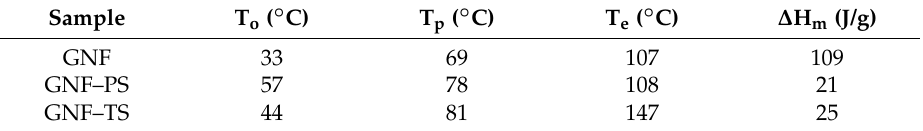
Table 2. DSC analysis of the GNF and the 5% loaded-GNF–PS and GNF–TS.